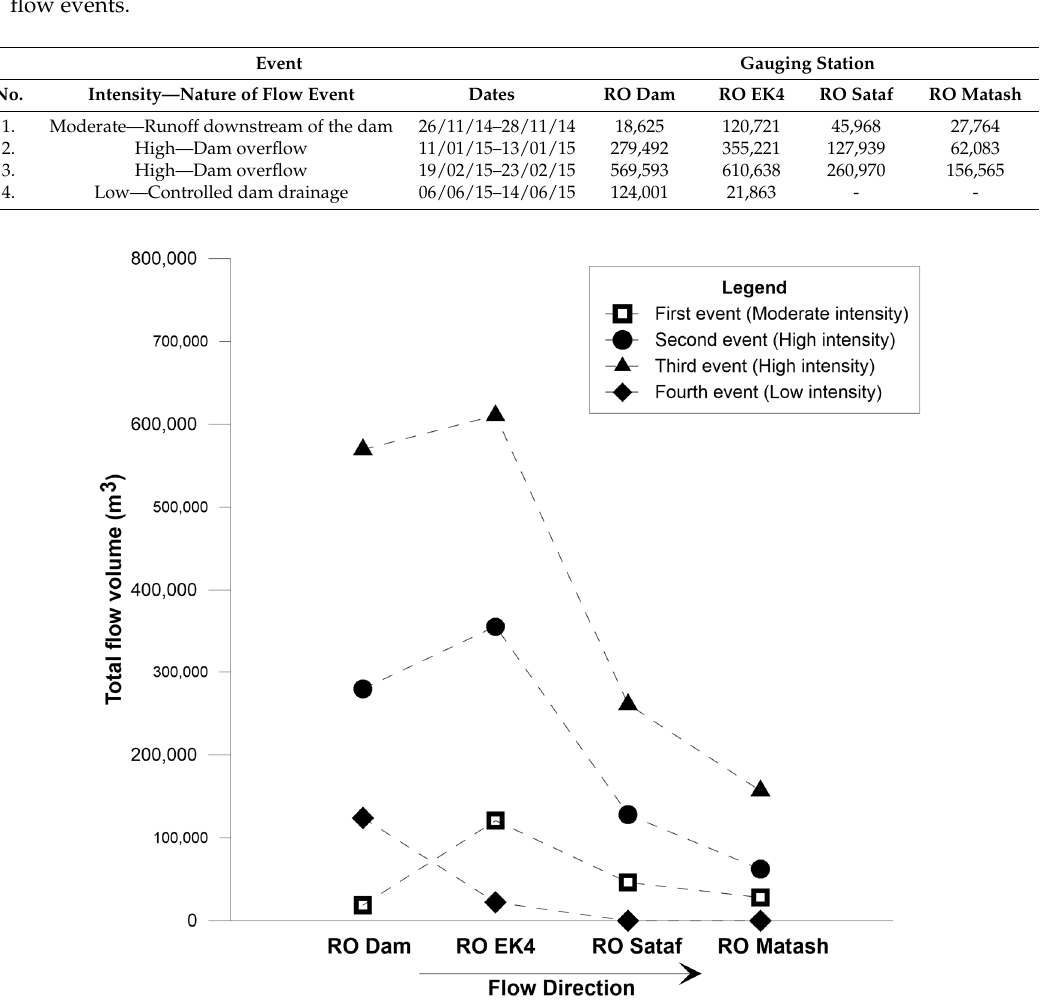
Figure 3. Total flow volume during the four runoff events at each monitoring site along the Soreq creek.